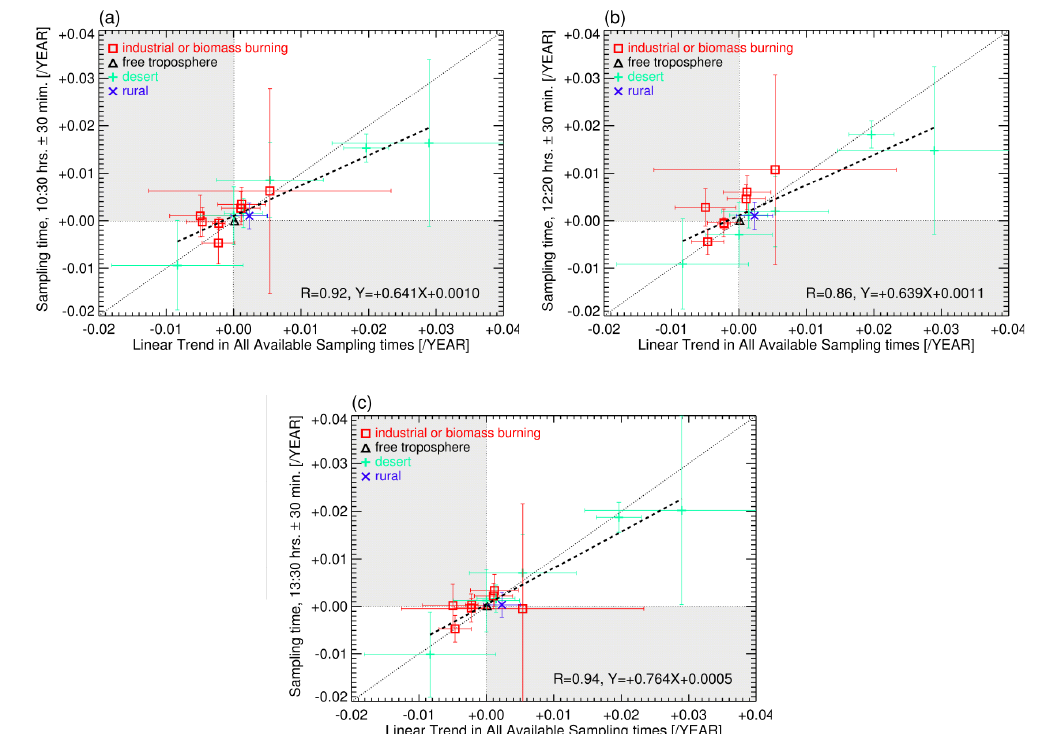
Figure 5. Scatter plots of comparison between the linear trends of all available measurements and those sampled around (a) 10:30 ± 30min, (b) 12:20 ± 30min, and (c) 13:30 ± 30min using the real-time AERONET AOT (550nm)